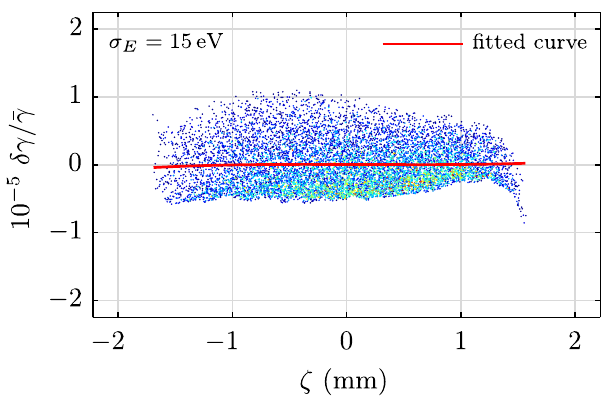
FIG. 12. A STRA simulation for a parameter set determined by ~ B ≡ 0 for i ∈ f 1 ; 2 ; 3 g . The gun is set g the condition B i ¼ i þ i 100 . 0 MV = m and ϕ 45 . 7 deg, while the buncher to E G ¼ G ¼ 14 . 1 MV = m and ϕ − 69 . 9 deg. The result- settings are E B ¼ B ¼ 15 eV for a bunch energy of ing energy spread is about σ E kin ¼ 3 . 9 MeV, i.e. σ 4 × 10 − 6 . The red line results E =E kin ¼ E kin kin ¼